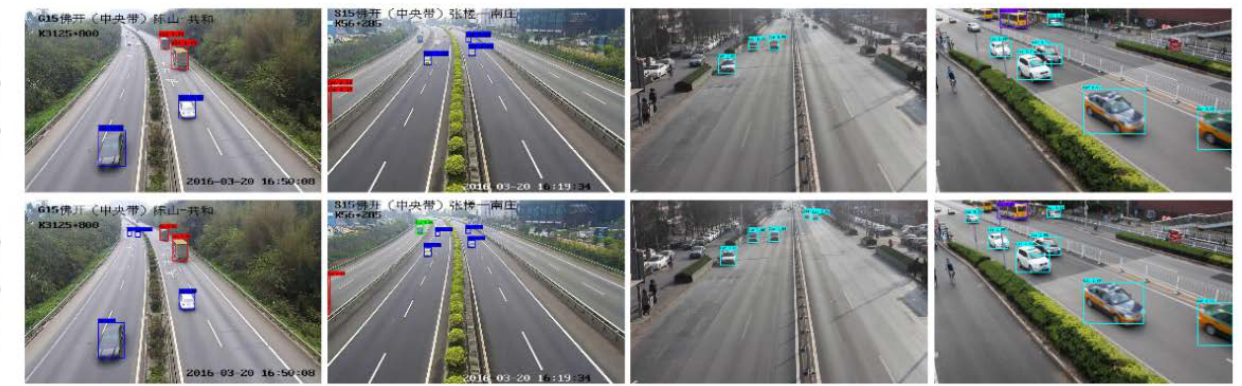
Figure 7. Detection Examples of YOLOv3 and E-YOLO (the visual enhanced YOLO) on LVSH (columns 1 and 2) and UA-DETRAC (columns 3 and 4). After plugged with the proposed attention structure and ensemble inference head, E-YOLO can easily detect the small-scale vehicles that are timely neglected by YOLOv3. The Chinese characters in the figures are the locations of the cameras, which are not used in our experiments. Best viewed on the screen.